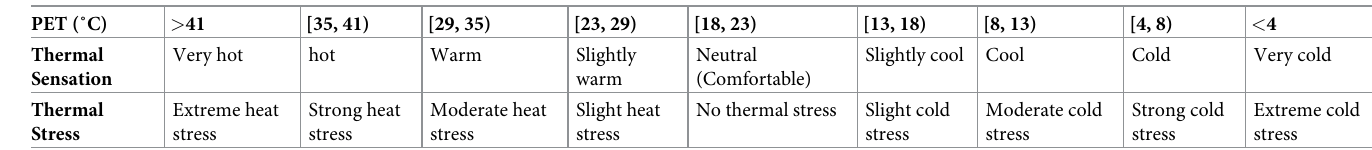
Table 2. Classification of thermal sensation/stress on the PET scale.